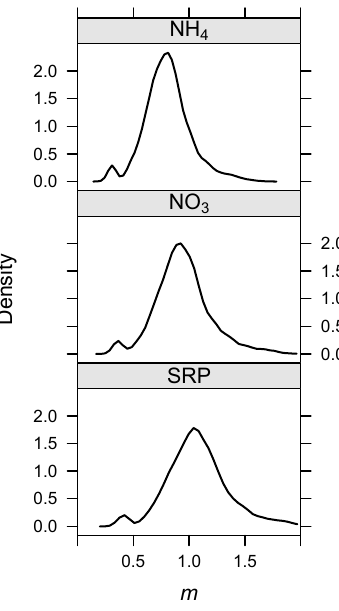
Fig. 3. Distribution of the scaling exponent, m , which relates uptake length of the 3 nutrients with distance from the headwaters. Lines are kernel densities based on a distribution of 10000 estimates of m given uncertainty in parameters used to derive m (Eq. 9, in text).